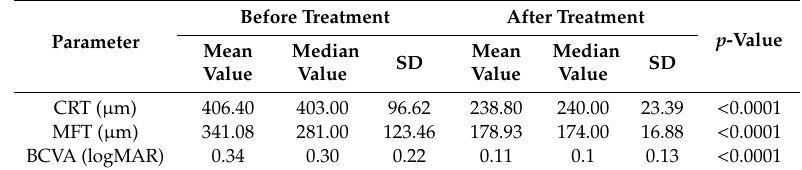
Table 2. Comparison of parameters of the a ff ected eye before and after treatment ( t -test for CRT and BCVA; Wilcoxon test for MFT). Parameter